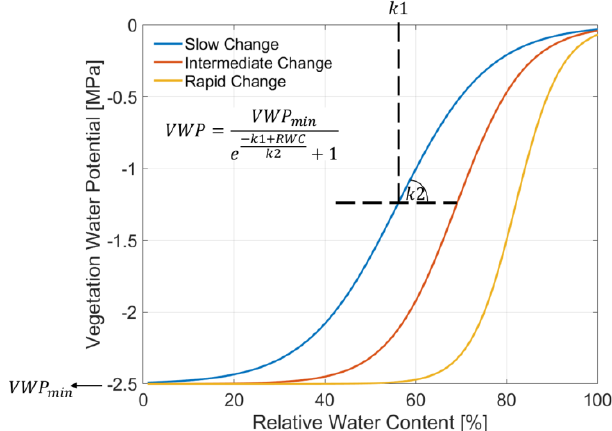
Figure 3. Modeled relation between relative water content (RWC) [%] and vegetation water potential (VWP) [MPa] adapted for winter wheat and assuming different rates from slow (blue) to intermediate (red) until rapid (orange) change. The inset equation, adopted from Zweifel and Häsler (2000) and Zweifel et al. (2001), integrates a minimum VWP (VWP min ) and specifies an inflection point ( k 1 ) and a rate ( k 2 ) of the change dynamic between RWC and VWP. k 1 and k 2 are also indicated schematically with dashed black lines.